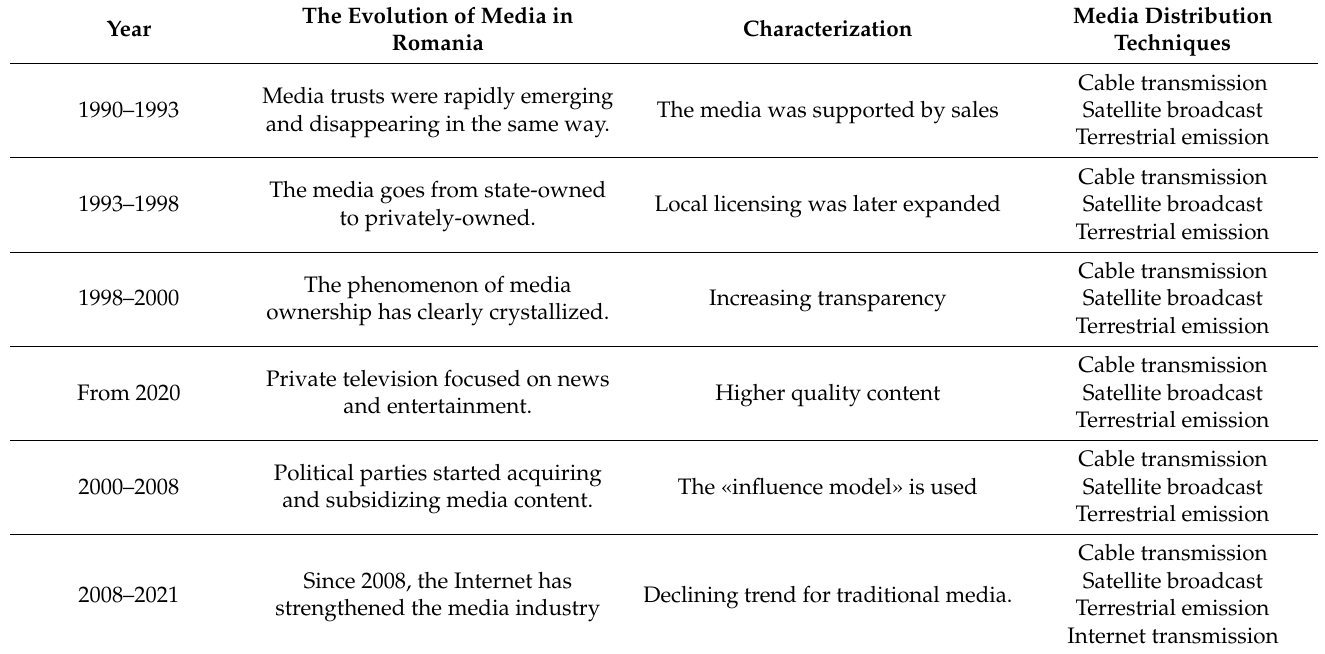
Table 1. The evolution of the media between 1990 and 2021, in